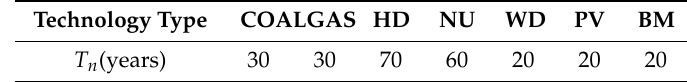
Table 7. Expected technical lifetimes of the power technologies of all types.